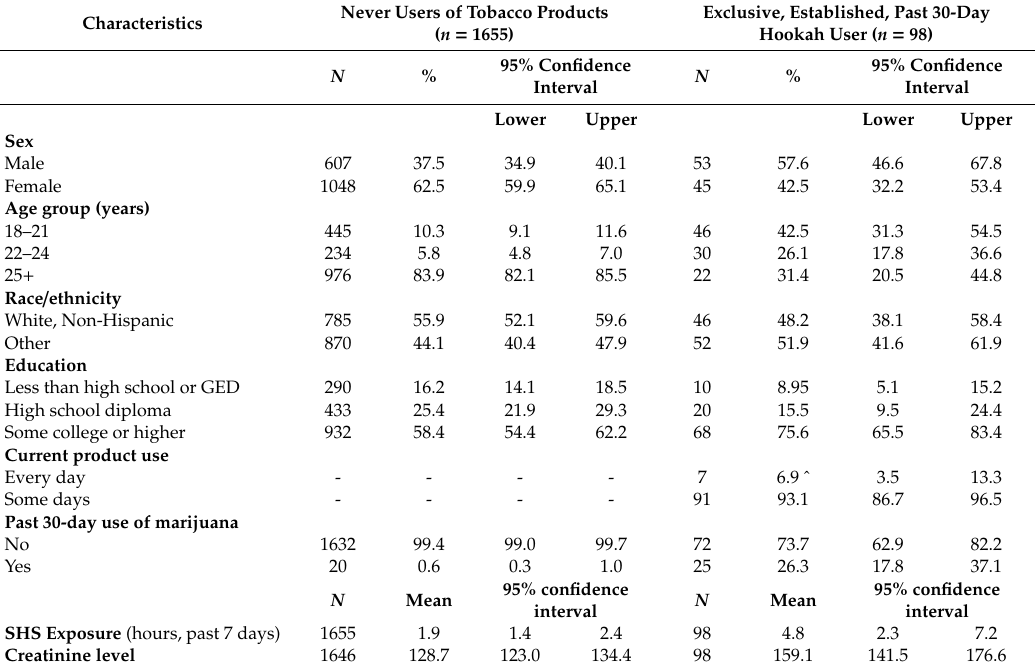
Table 2. Weighted sample characteristics * ( n =